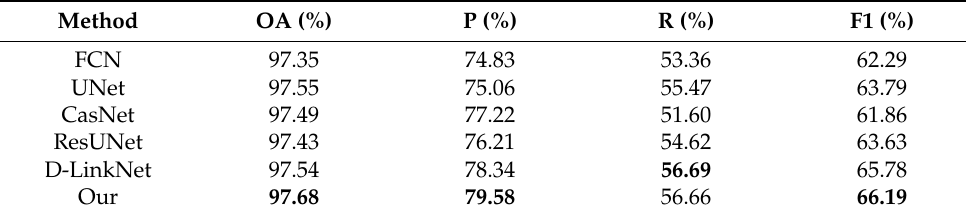
Table 2. Results of the comparative experiments on the Massachusetts dataset.